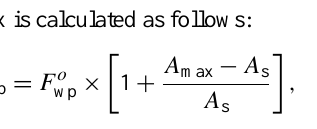
bic polynomial fit (Eq. 6, after Bjerrum et al., 2006) of the ETOPO-5 hypsometric curve (National Geophysical Data Center,